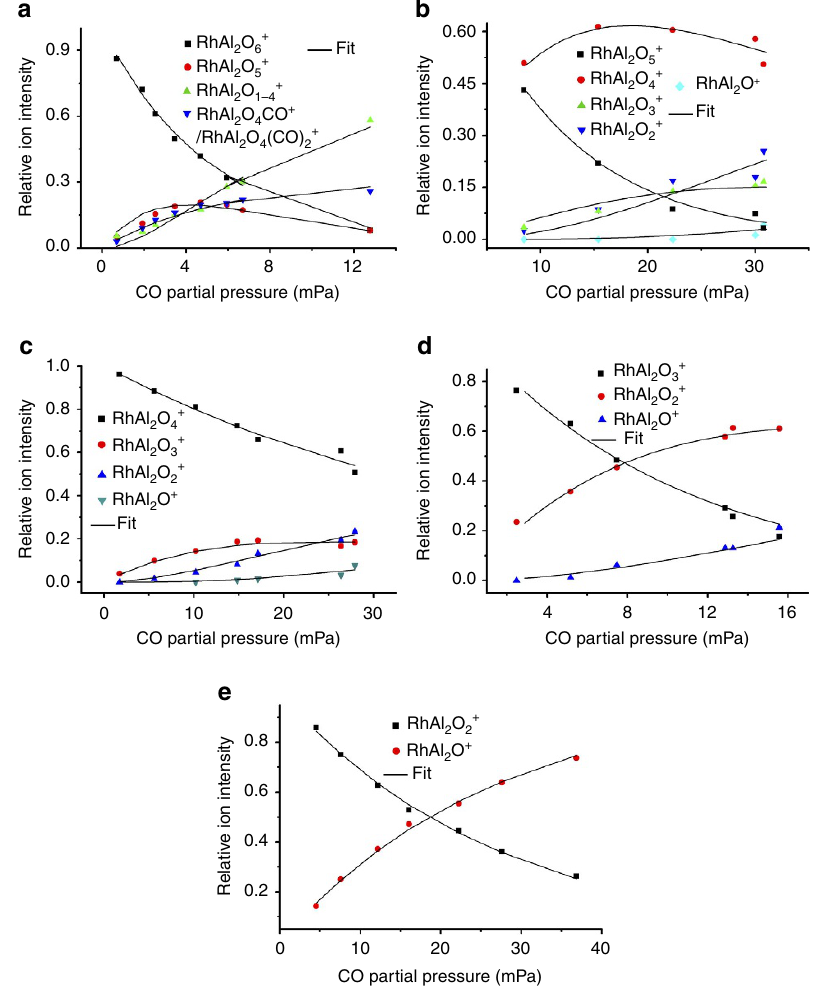
Figure 3 | Reaction kinetics. Variation of ion intensities with respect to the partial pressures of CO in RhAl 2 O m þ ( m ¼ 6 (cid:2) 2) þ CO are shown ( a – e ). The solid lines are fitted to the experimental data points by the least-square procedure. The Rh þ (1,0,0) ions (Fig. 2) are mostly generated during cooling of the RhAl 2 O 3 þ and RhAl 2 O 2 þ cluster ions through collisions with He gas in the ion trap reactor; thus, the ion intensity of Rh þ (nearly independent on the CO partial pressure) is excluded in the fitting. See Supplementary Table 1 for details of the determined rate constant values. NATURE COMMUNICATIONS|7:11404|DOI: